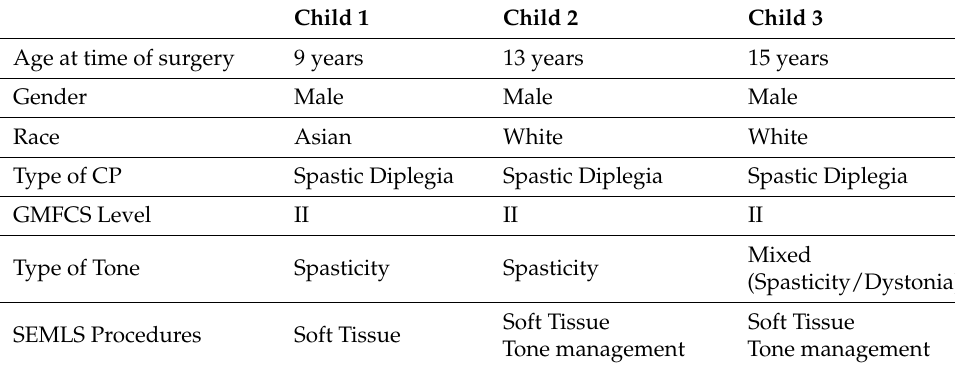
Table 1. Child demographics and clinical